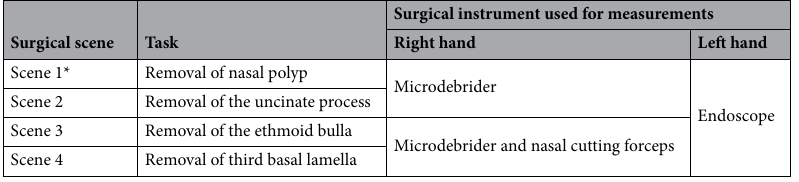
Table 1. Definition of surgical scene and instruments used for measurements 6 . *Only when a patient has nasal polyps.